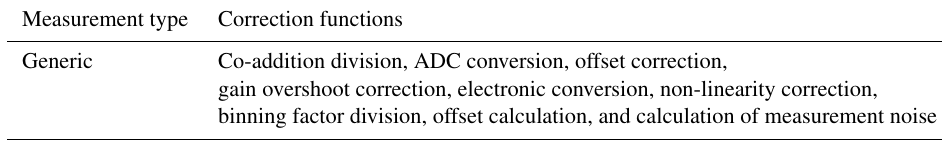
Table 5. Correction functions for the different measurement types. Generic corrections are applied to all measurement types.